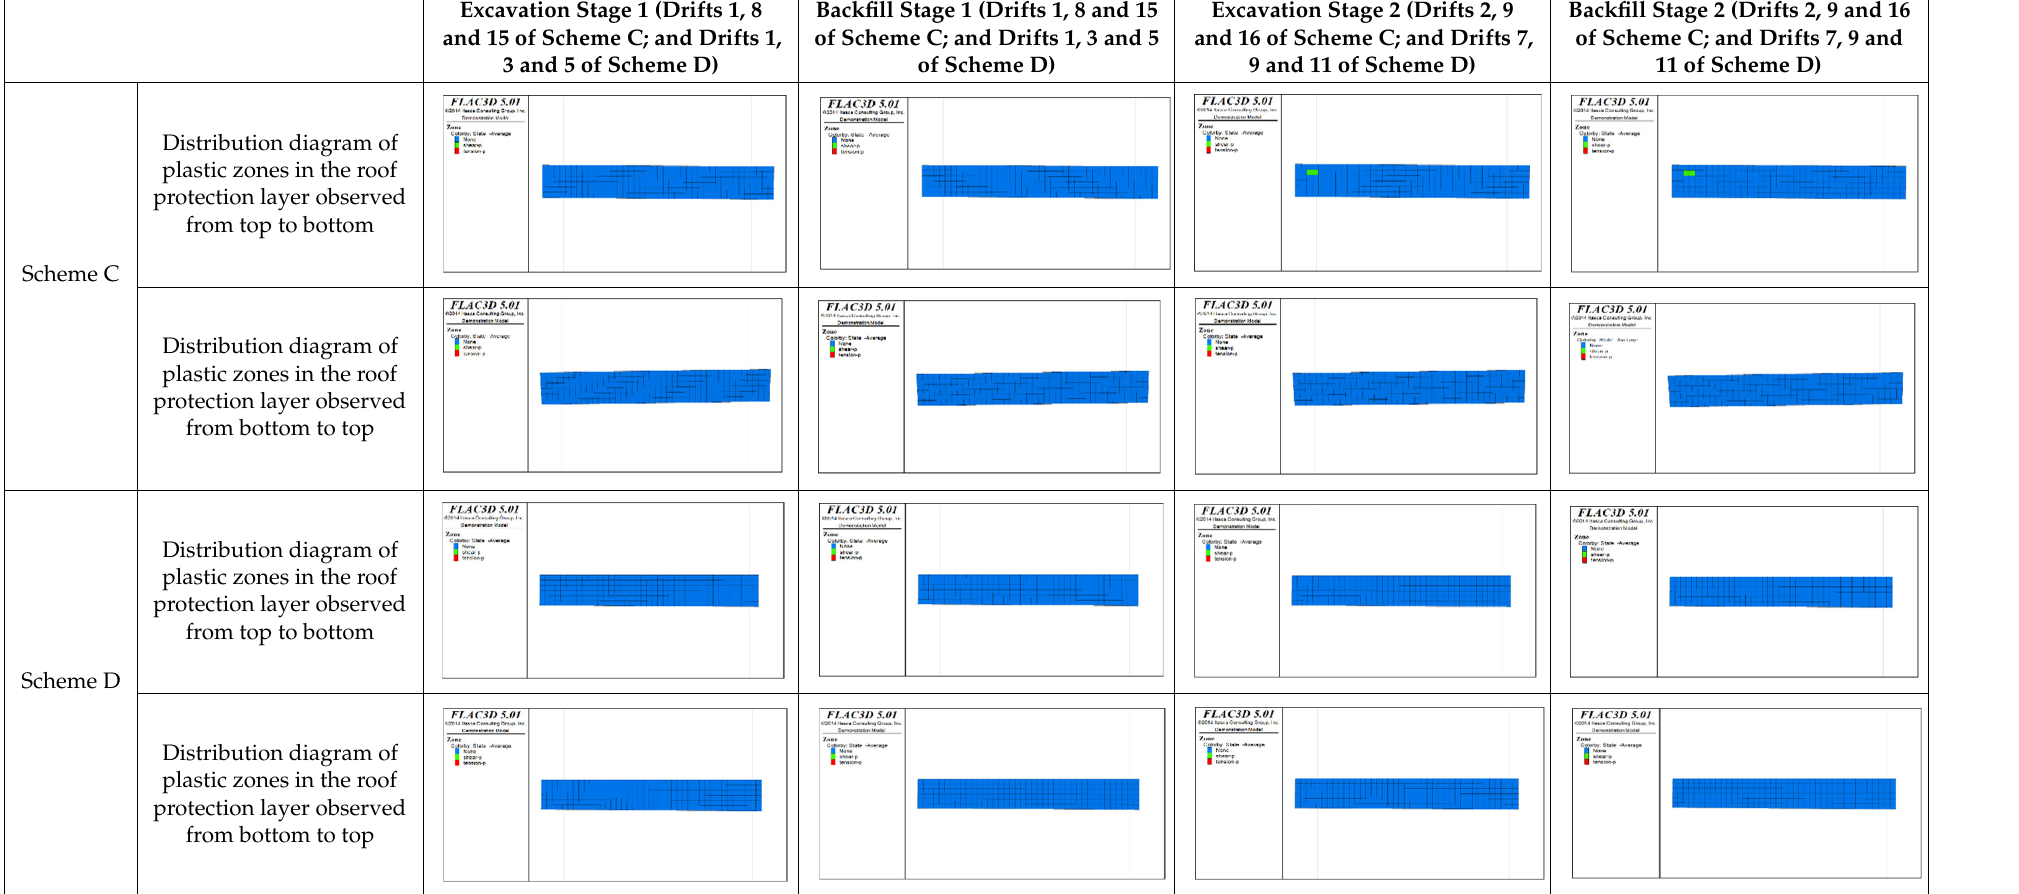
Table 6. Distributions of roof protection layer plastic zones under Schemes C and D (excavation stages 1 and 2).